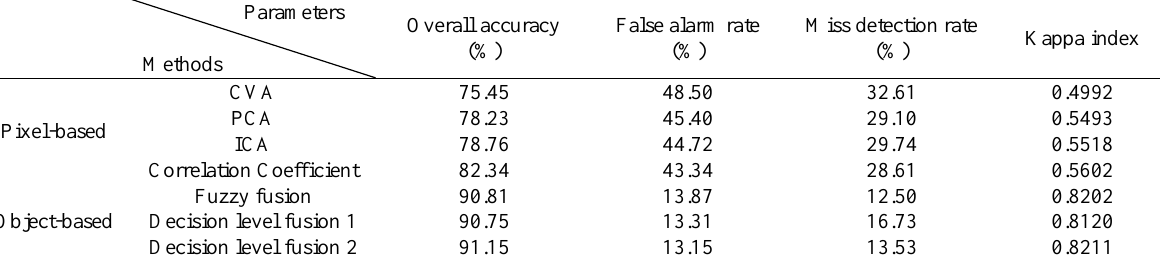
Figure.9 The results of change detection (a) Decision level fusion 1 (b) Decision level fusion 2 (c) Correlation coefficient method based on the pixels Table.2 Precision of change